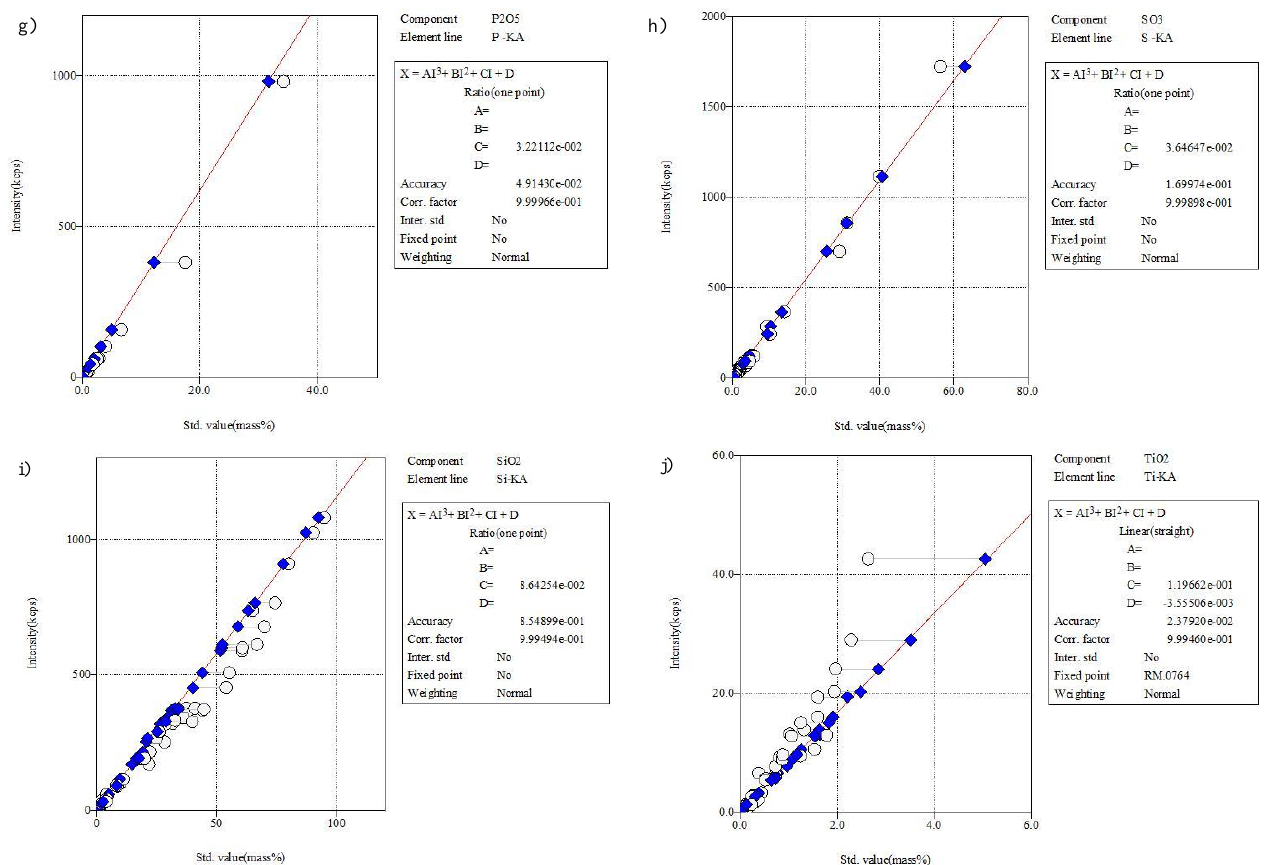
Figure 1. Calibration curves for ( a ) Al 2 O 3 , ( b ) CaO, ( c ) Fe 2 O 3 , ( d ) K 2 O, ( e ) MgO, ( f ) Na 2 O, ( g ) P 2 O 5 , ( h ) SO 3 , ( i ) SiO 2 and ( j ) TiO 2 .